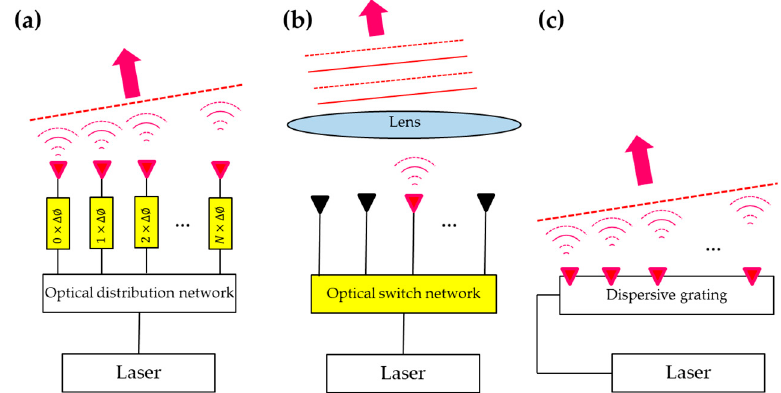
Figure 1. Three optical beam steering techniques: ( a ) optical phased array (OPA), ( b ) focal plane array (FPA), ( c ) dispersive grating diffraction.